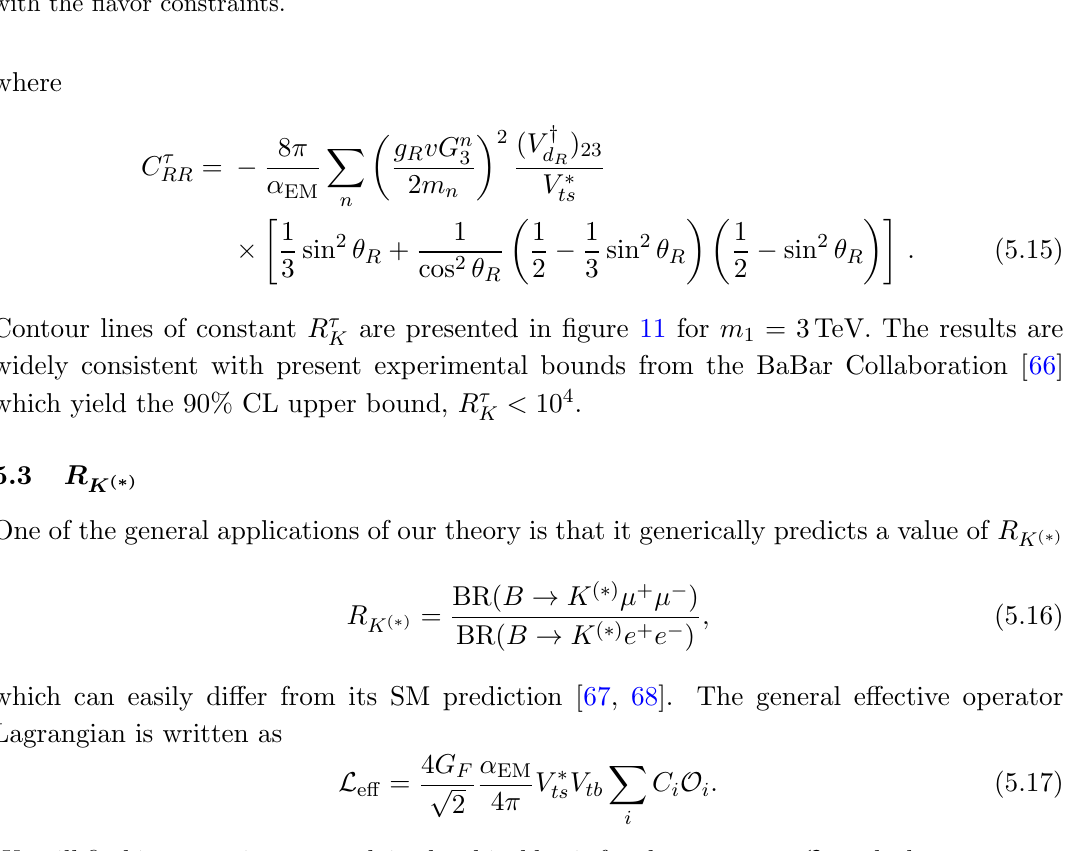
) 23 j ], for values of ( V y d R